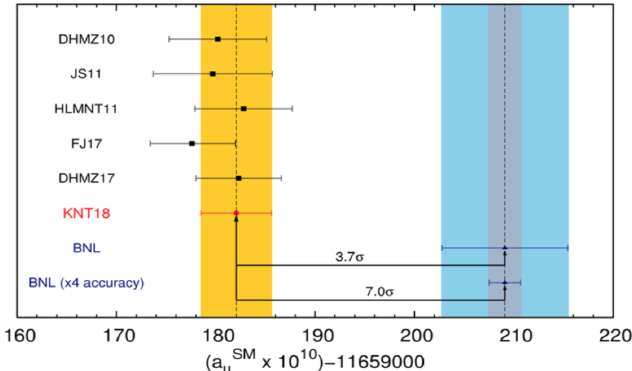
Figure 2. Comparison between theoretical and experimental